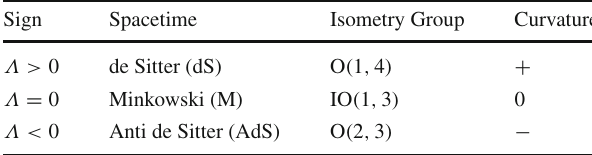
Table 1 Background geometries for vacuum